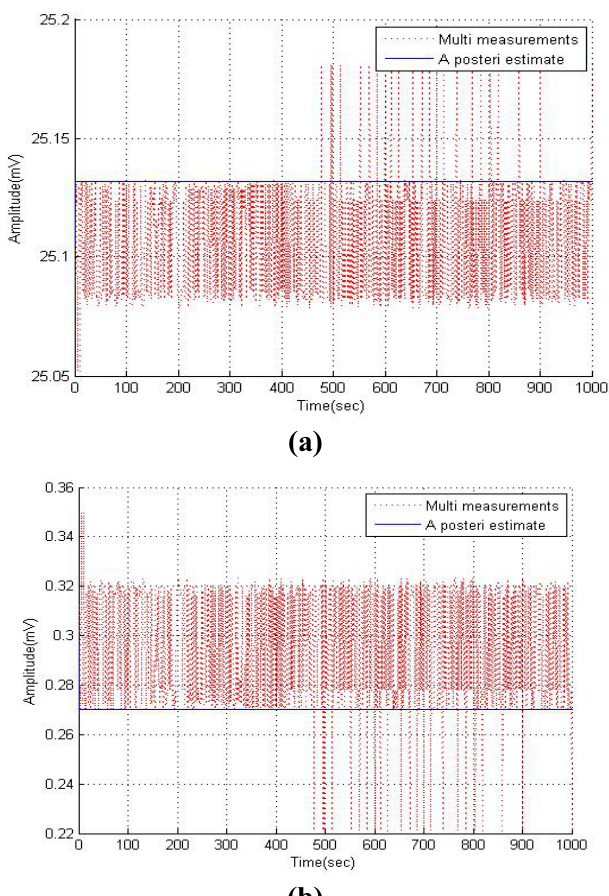
sensor. (b) Humidity sensor. (c) Oxygen